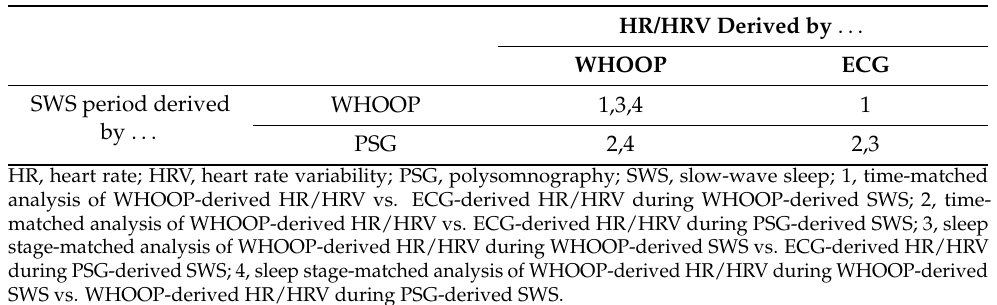
Table 1. Analyses of agreement overview. SWS period